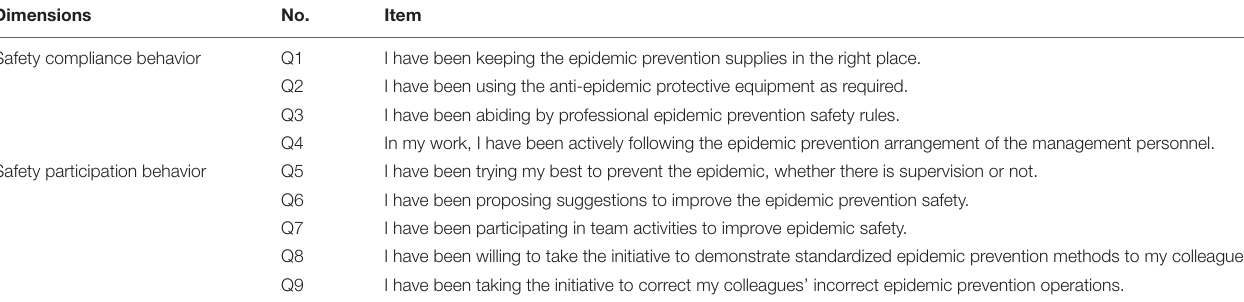
TABLE 1 | Safety behavior scale.